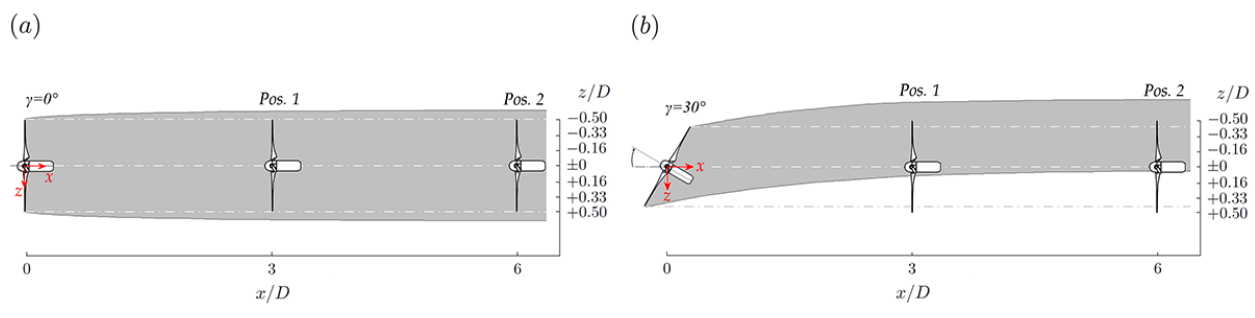
Figure 2. Top view of the aligned downstream turbine operated in the wake of an upstream turbine at the two different positions: x/D = 3 and x/D = 6. The wake flow is indicated for (a) γ T1 = 0 ◦ and (b) γ T1 = 30 ◦ .